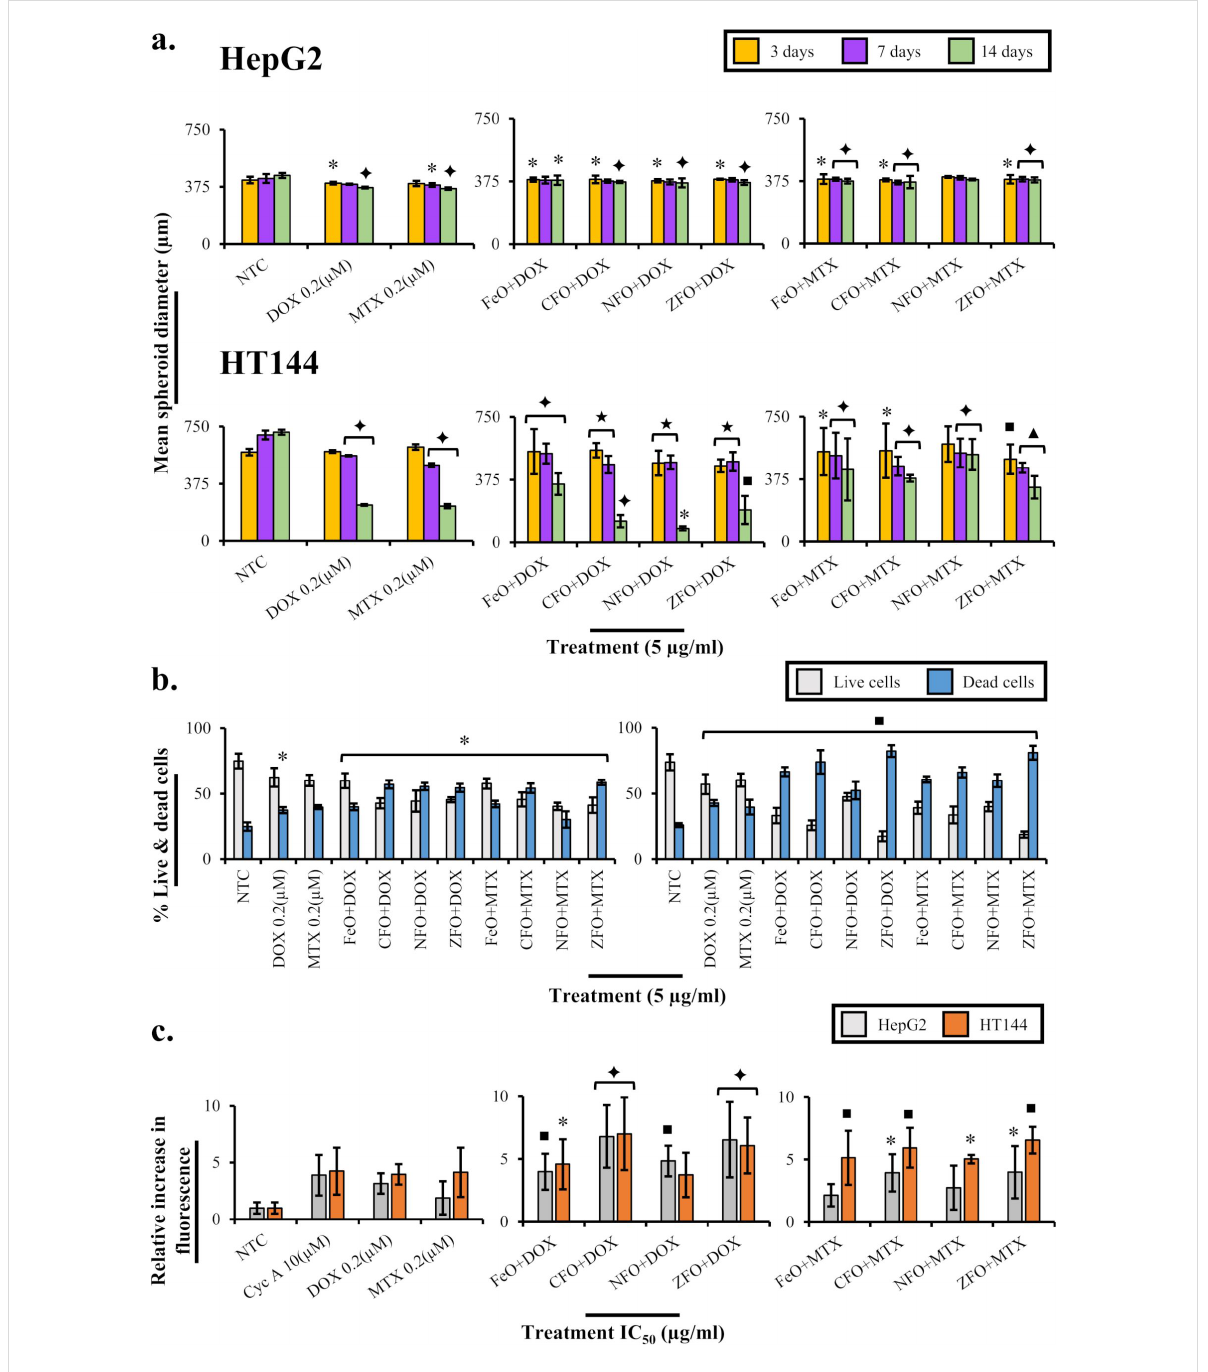
Figure 9: (a) Bar charts indicating changes in HepG2 and HT144 spheroid diameters upon treatment with drug-loaded (DOX and MTX) MFe 2 O 4 (M = Fe, Co, Ni, Zn) NPs at 5 µg/mL for three, seven, and fourteen days. Controls included free drugs (DOX and MTX, 0.2 µM each) and NTC. After each time point, an average spheroid diameter was calculated by the ImageJ software. The plotted data indicates mean ± SD of multiple readings covering maximum and minimum diameter ranges of spheroids. (b) From left to right: bar charts indicating viability and death percentage in treated HepG2 and HT144 3D spheroids after 14 days. Live and dead cells in each sample were counted using the trypan blue assay. The data plotted indi- cates mean ± SD of three replicates. p < 0.05 (one asterisk), p < 0.01 (black square symbol), p < 0.005 (black diamond symbol), p < 0.001 (black star symbol), and p < 0.0005 (black triangle symbol), paired two-tailed t -test when compared to NTC. (c) Bar charts represent multidrug resistance (MDR) pump inhibition (mean ± SD) in HepG2 and HT144 cells treated with NPs+drugs for 24 h. Controls included NTC, free drugs (DOX and MTX, 0.2 µM each), and the MDR inhibitor cyclosporin A (Cyc A = 10 µM). The inhibition of MDR pump activity was determined by the increase in fluorescence relative to NTC. p < 0.05 (one asterisk), p < 0.01 (black square symbol), and p < 0.005 (black diamond symbol), paired two-tailed t -test when samples were compared to free drug